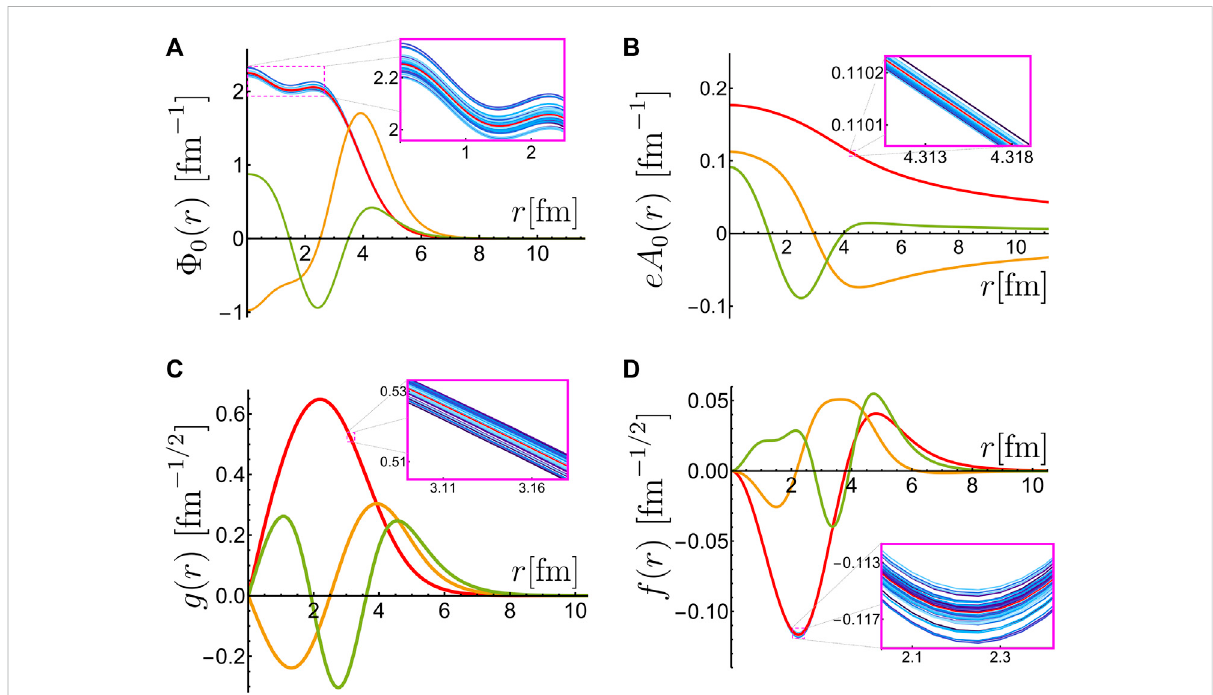
FIGURE 2 First three principal components in red, orange, and greenrespectively, for Φ 0 ( r ) (A) , eA 0 ( r ) (B) , the fi rst g ( r ) for neutrons (C) , and the sixth f(r) for protons (D) in 48 Ca. The second and third components (in orange and green) have been re-scaled arbitrarily for plotting convenience. The 50solutionsusedinthetrainingsetareshownindifferentshadesofblueineach fi gure.Thespreadofsuchsolutionsisbarelyvisiblefor Φ 0 ( r )and f ( r ), and almost undetectable for the other two cases. The spread is further enhanced in the inset plots within the magenta squares in each sub fi